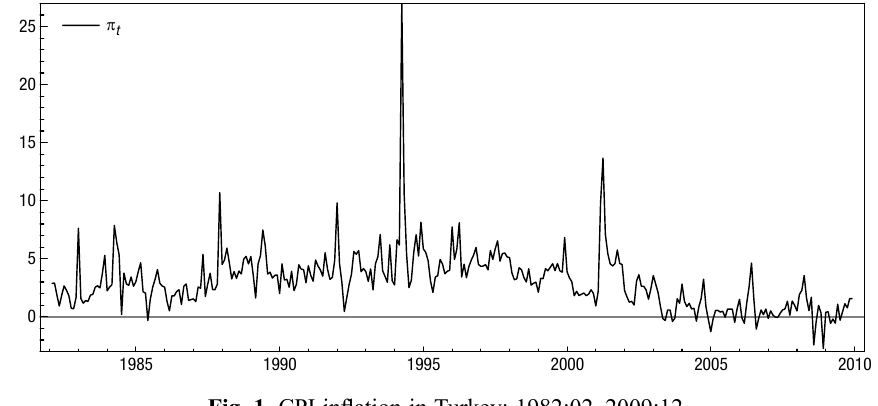
Fig. 1. CPI inflation in Turkey: